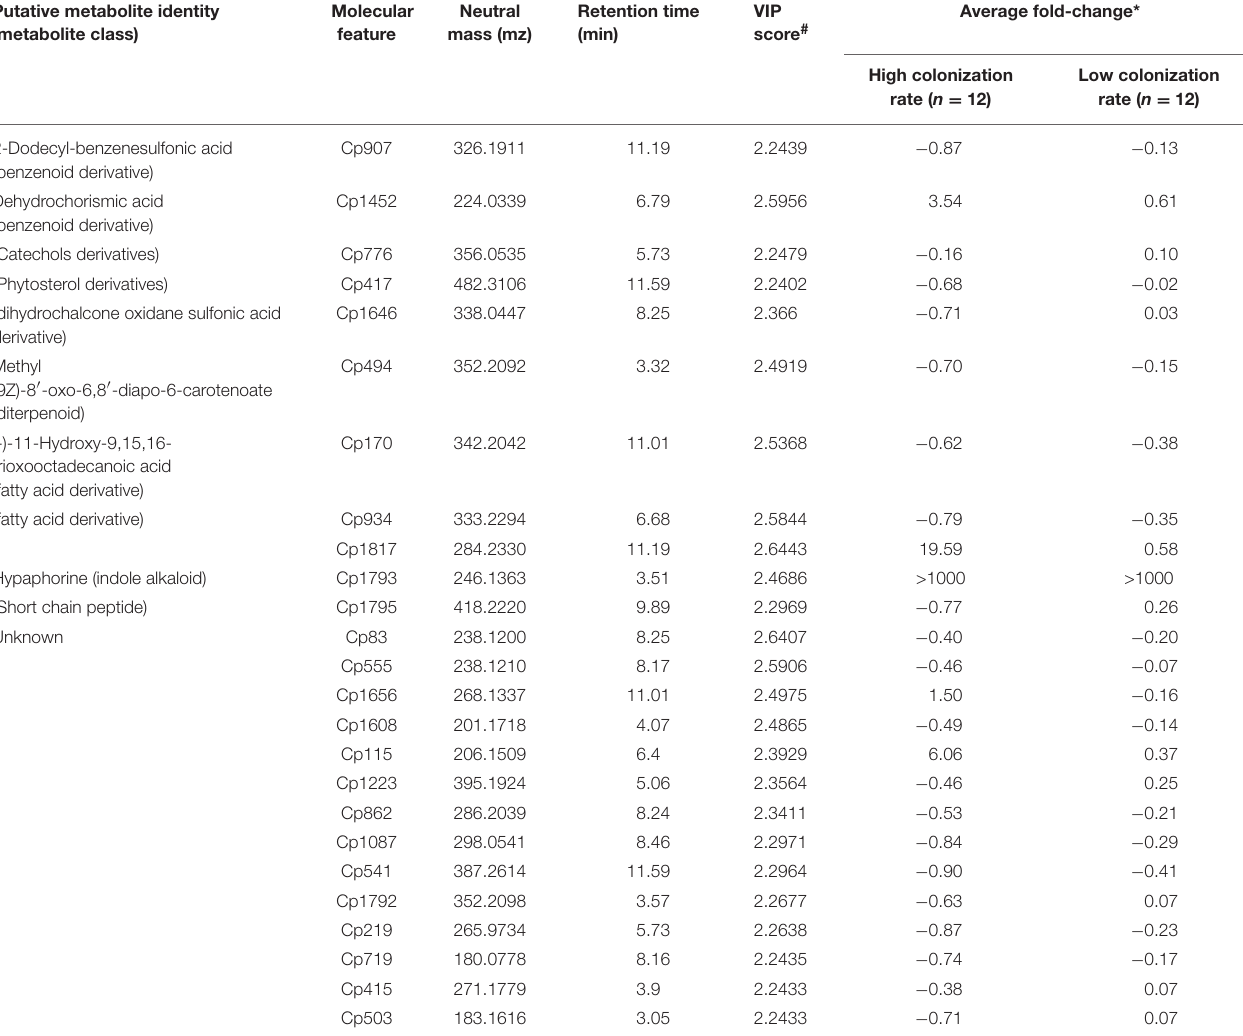
TABLE 3 | Putative identities and response levels in Pisolithus- treated root tips of top-25 important molecular features identified in PLS-DA (LCMS-ESI + mode). Putative metabolite identity (metabolite